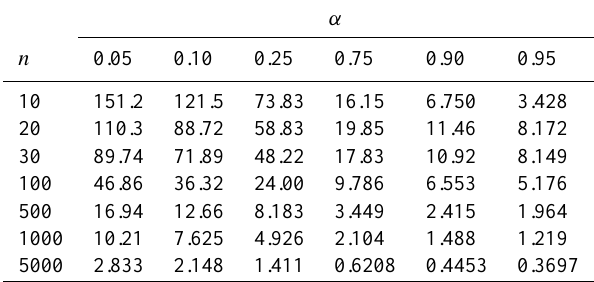
Table 3. Critical values of the PPCC test statistic for λ = 0 . 6. Re- ported values are 1000(1 − r ).